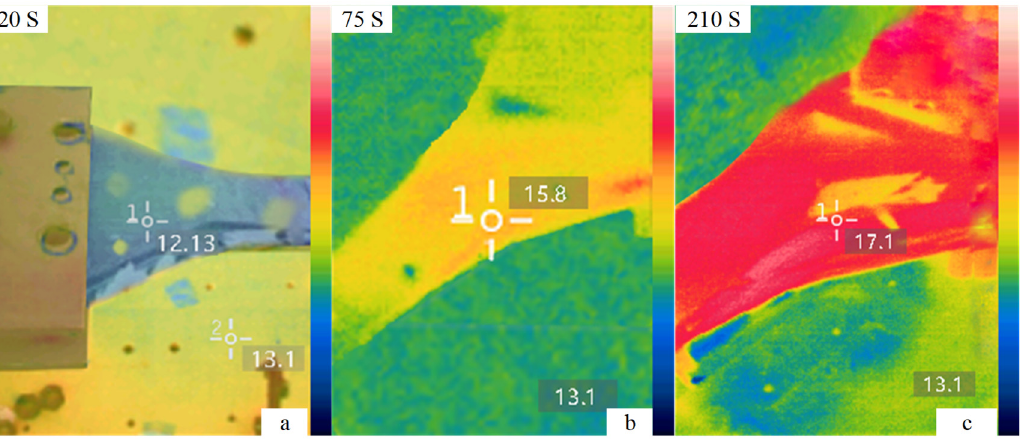
Figure 11. Infrared thermal images at different times. ( a ) Infrared thermal image at 20 s ( b ) Infrared thermal image at 75 s ( c ) Infrared thermal image at 210 s